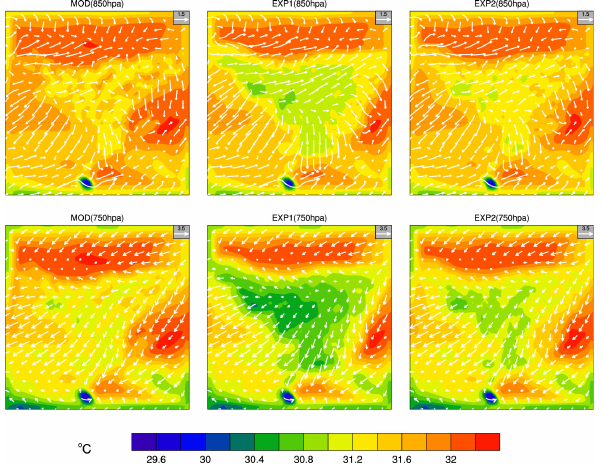
Fig. 11. Simulated horizontal winds (ms − 1 ) and air temperature ( ◦ C) at 850hPa from the MOD, EXP1 and EXP2 simulations at 13:00BT, 6 July 2004.